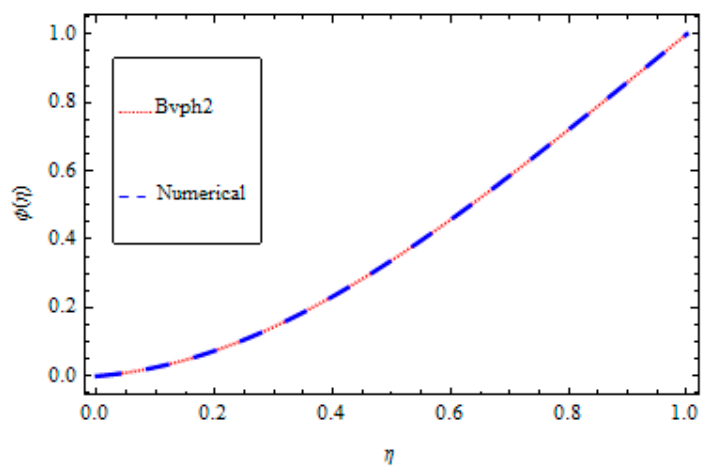
Figure 7. Graphical comparison of the HAM and numerical solution.